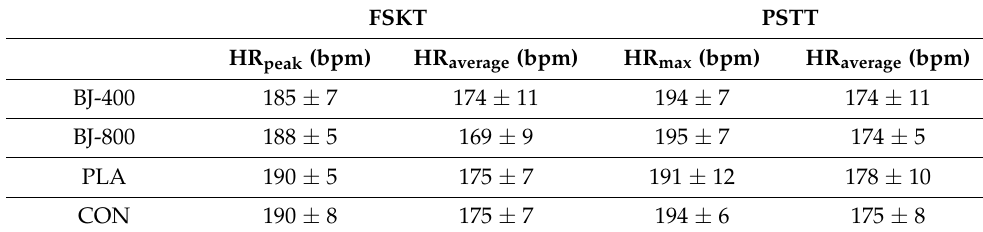
Table 5. Heart rate responses to Frequency of Speed Test and Progressive Specific Taekwondo